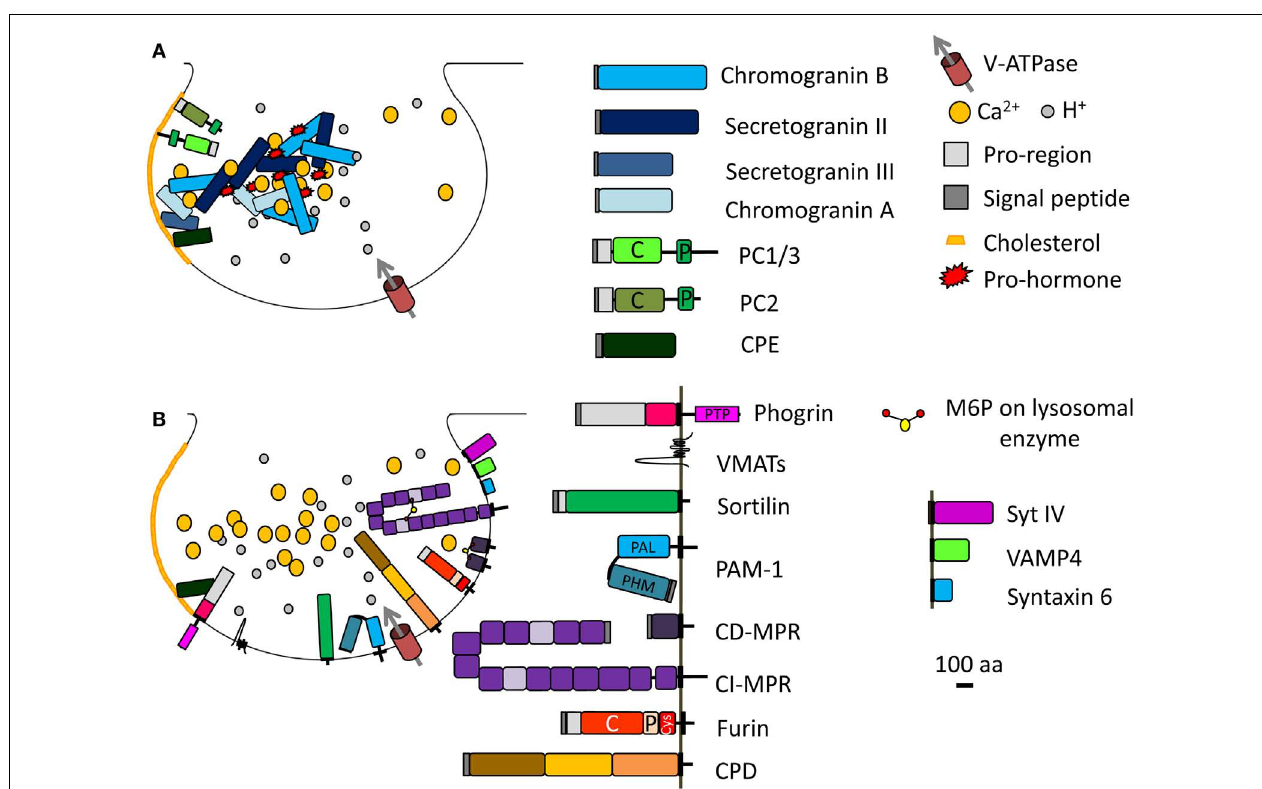
(synaptotagmin IV,VAMP4, syntaxin 6) are replaced during the maturation process. Proteins known to enter immature SGs are drawn approximately to scale (except for the vacuolar proton pump,V-ATPase, andVMATs). PC, prohormone convertase; C, catalytic domain; P, P domain; PTP, protein-tyrosine phosphatase; PHM, peptidylglycine α -hydroxylating monooxygenase; PAL, peptidylglycine α -amidating lyase; CI-MPR contains 15 domains; CPD contains three similar domains; Cys, cysteine-rich